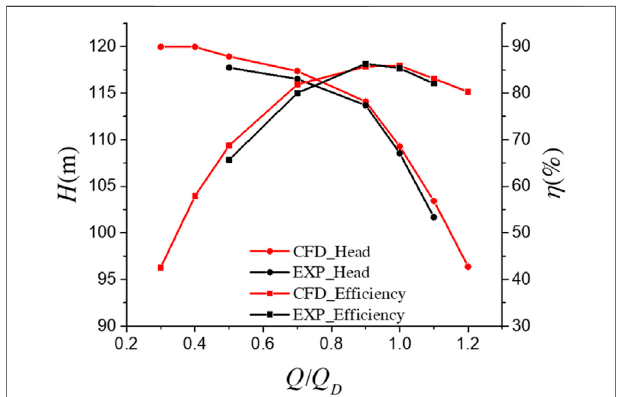
FIGURE 3 | Comparison between the simulation results and the experimental results.